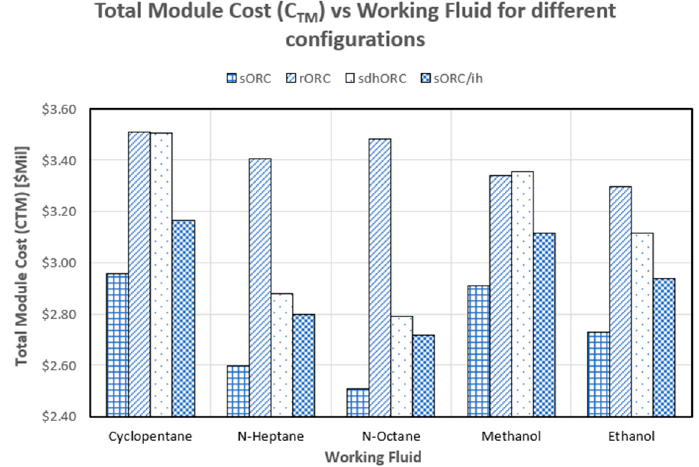
Figure 7. Total Module Cost vs working fluids and cycle configurations. 363